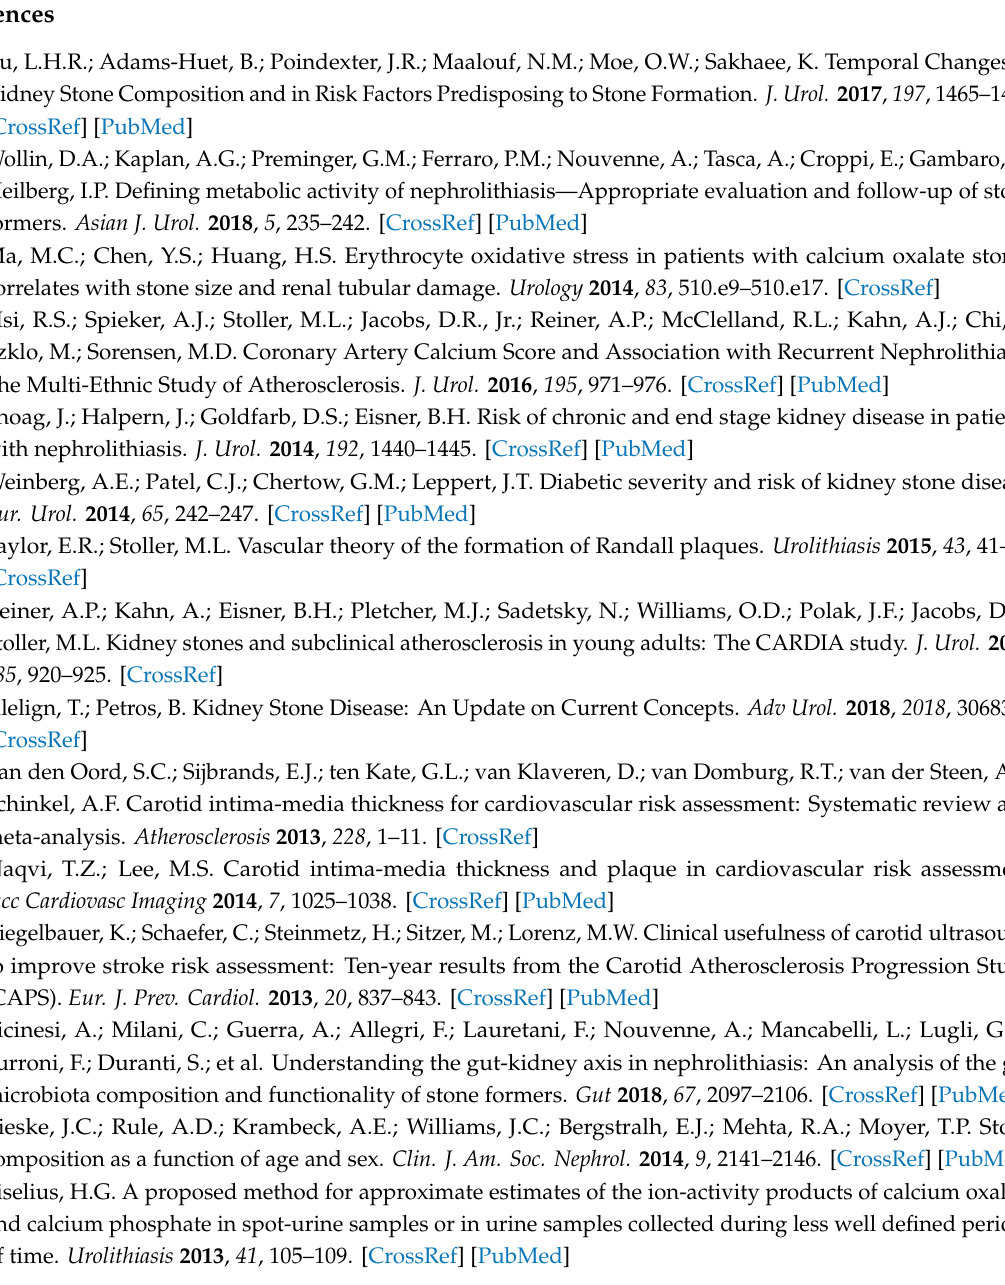
Table S1: Stone composition in patients with kidney stone